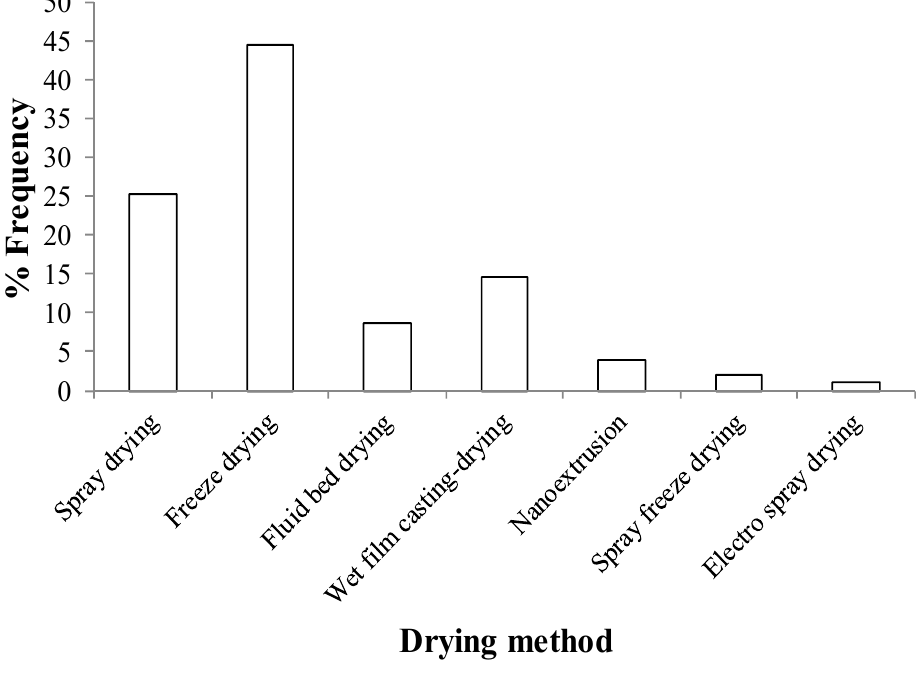
Figure 5. The usage frequency of various drying methods in the studies reported in Table 2. The sample size for the analysis here is 103, even though the number of publications in Table 2 is 92, because some studies compared two drying methods.